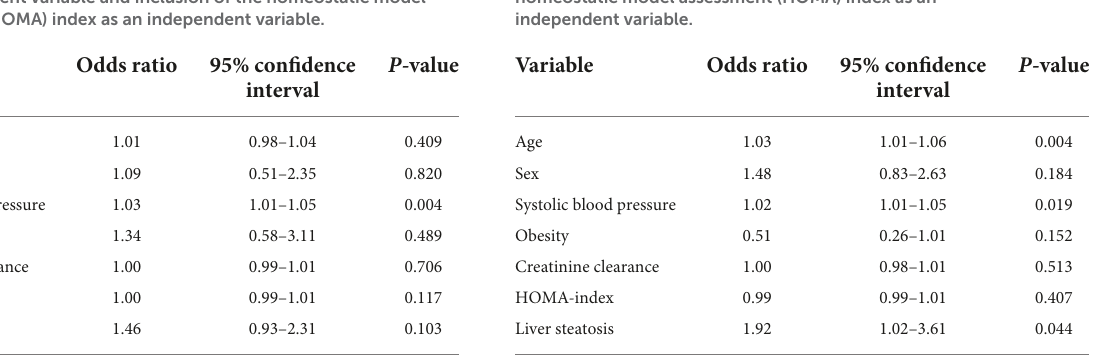
TABLE 8 Logistic regression analysis with left ventricular diastolic dysfunction as the dependent variable and inclusion of the homeostatic model assessment (HOMA) index as an independent